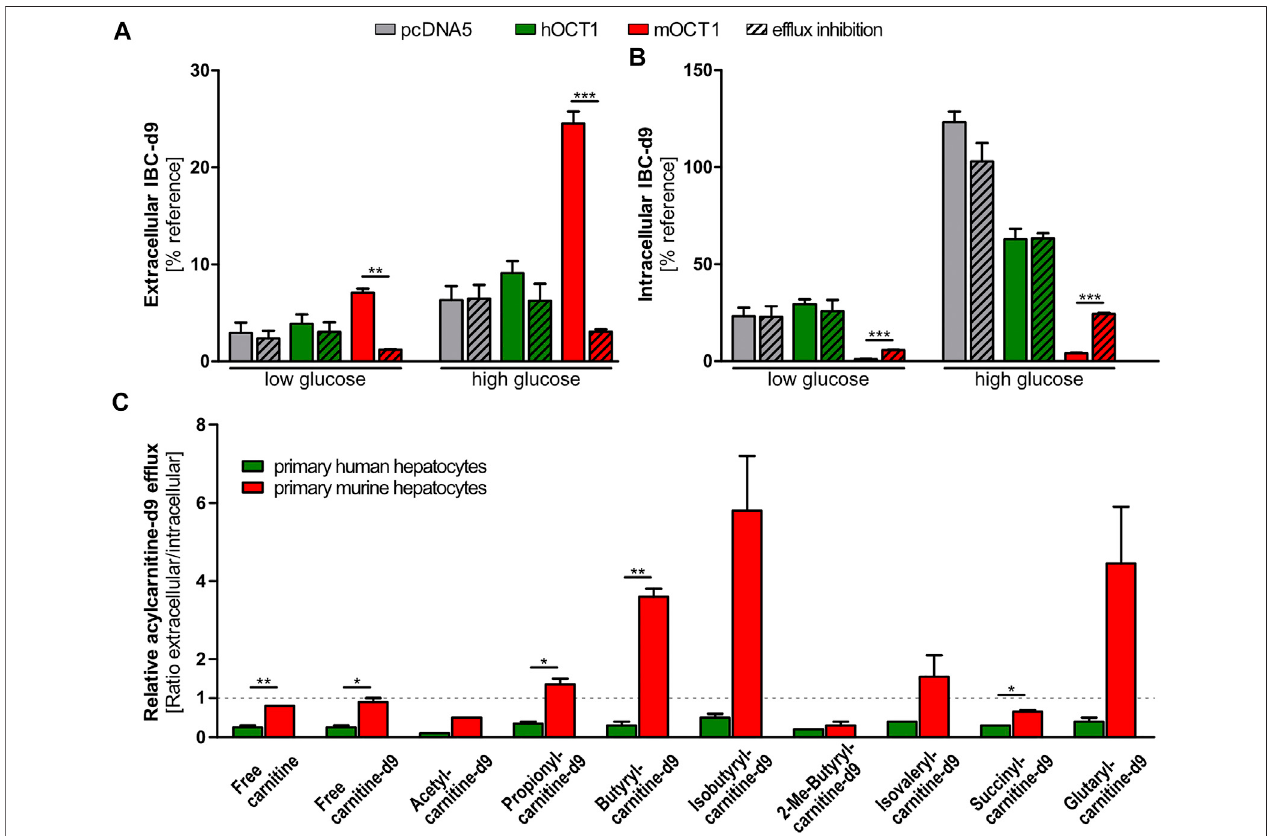
FIGURE 5 | Ef fl ux of acylcarnitines. (A) Ef fl ux of acylcarnitines after incubation with carnitine-d9 led to increased extracellular and reduced intracellular isobytyrylcarnitine and other acylcarnitine species. Inhibition of OCT1 by desipramine (indicated with ‘ + ‘ ) reduced or hindered this ef fl ux. (B) Murine and human primary hepatocytes revealed distinguishable patterns of intra- and extracellular acylcarnitine species after preloading with deuterated carnitine (carnitine-d9). Again, only experiments with mouse OCT1 showed a consistent ef fl ux activity of mOCT1 (red columns). Glucose concentration in the medium may change metabolic pathwaysbutasseen,therelativeeffectsofhOCT1andmOCT1werethesameirrespectiveofglucosesupply. (A) and (B) Dataarerepresentedasthemean ± SEMfrom at least three independent experiments. Normalization was conducted by comparison to intracellular carnitine-d9 post ef fl ux. (C) Ef fl ux from primary murine or human hepatocytes appears different for several acylcarnitine species. Measurement in supernatant medium and in cells showed increased ef fl ux by murine hepatocytes for most investigated acylcarnitines. Data are represented as the mean ± SEM. Statistical analysis of two groups were performed using the Student ’ s t -test,* p < 0.05; * p < 0.01; *** p <